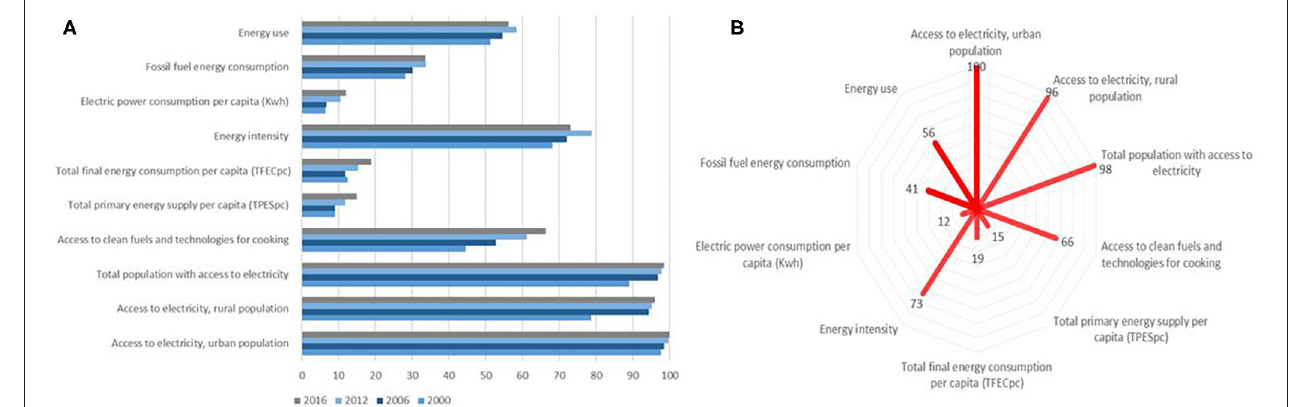
FIGURE 9 | Energy indicators (normalized) — Paraguay (2000, 2006, 2012, 2016).